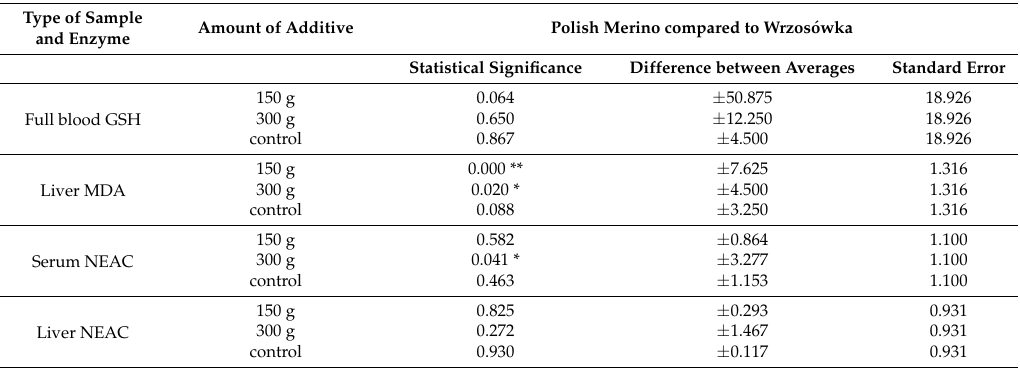
Table 5. Differences between the level of oxidative status indicators for each pair of breeds. Type of Sample and